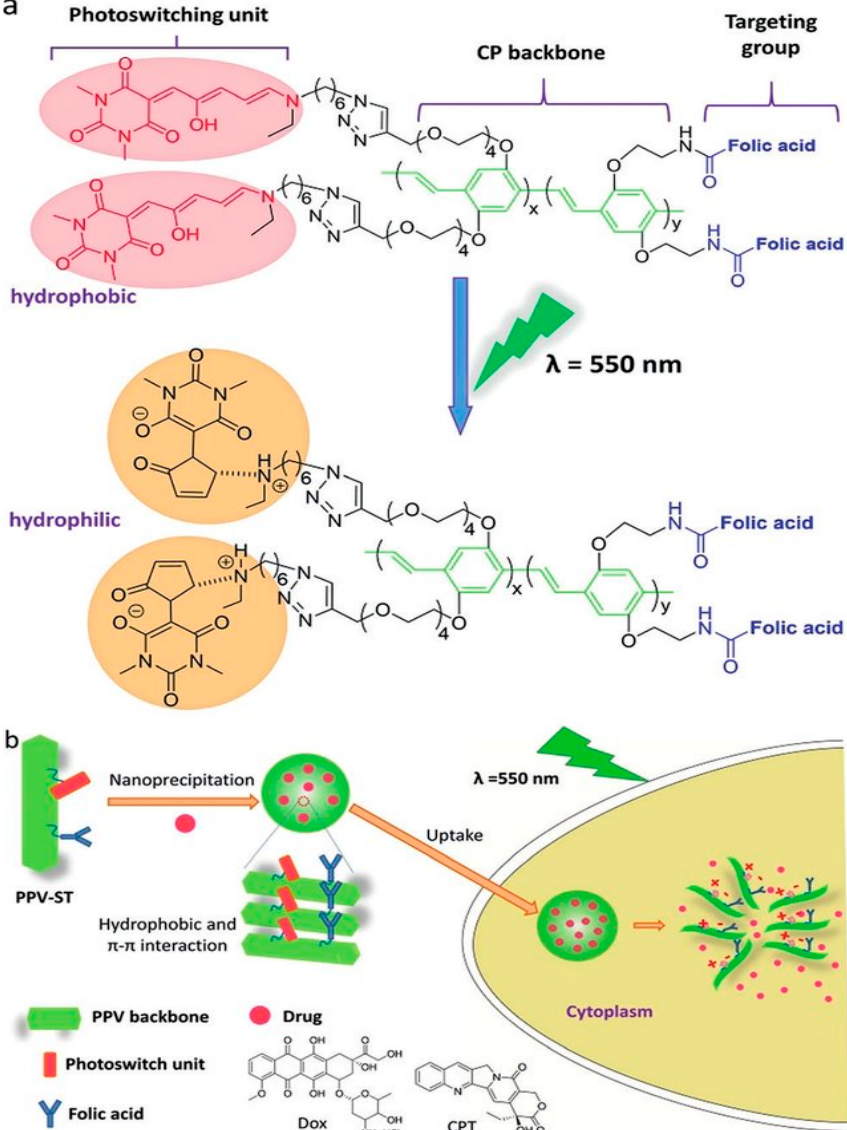
Figure 7. ( a ) The chemical structure of PPV ‐ ST conjugated polymer and its structural change un ‐ der visible light ( λ = 550 nm) irradiation; ( b ) Schematic representation of the formation of drug ‐ loaded PPV ‐ ST ‐ NP nanoparticles and structural change upon irradiation with visible light ( λ = 550 nm) leading to the drug release in cells. Reprinted with permission from [184]. Copyright 2018 John Wiley and Son.